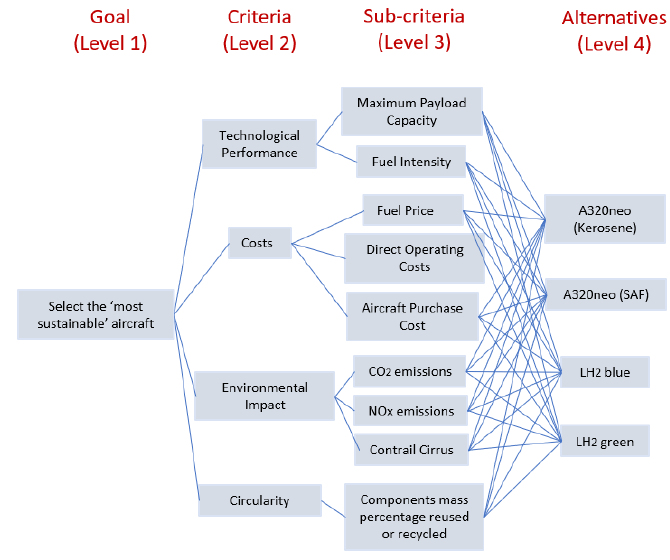
Figure 1. The AHP hierarchy structure of the aircraft process.